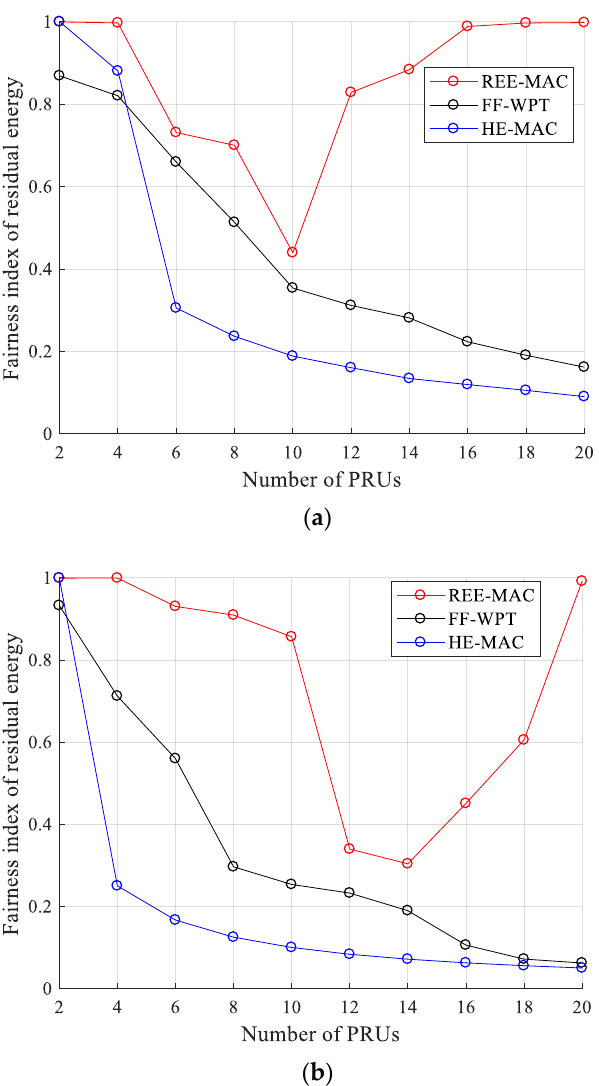
Figure 10. Fairness index for residual energy: ( a ) packet size of 100 bytes; ( b ) packet size of 200 bytes. However, in FF-WPT and HE-MAC, the fairness index for residual energy decreases as the number of PRUs in the network increases. As depicted in Figure 7, the gap in transmission opportunities between PRUs increases as the average freezing time of PRUs increases. This gap increases the difference between the energy consumed by individual PRUs. Therefore, the fairness index for residual energy gradually decreases as the difference between the residual energy of individual PRUs increases. Quantitatively, when the PRUs transmit 100- and 200-byte packets, the fairness index for residual energy of REE-MAC is 95.34% and 116.23% higher than that of FF-WPT, respectively. It is also 165.88% and 276.00% higher compared with that of HE-MAC, respectively. Figure 11a,b illustrate the fairness index for throughput for 100- and 200-byte packets, respectively. The fairness index for throughput ( F th ) can be calculated by Equation